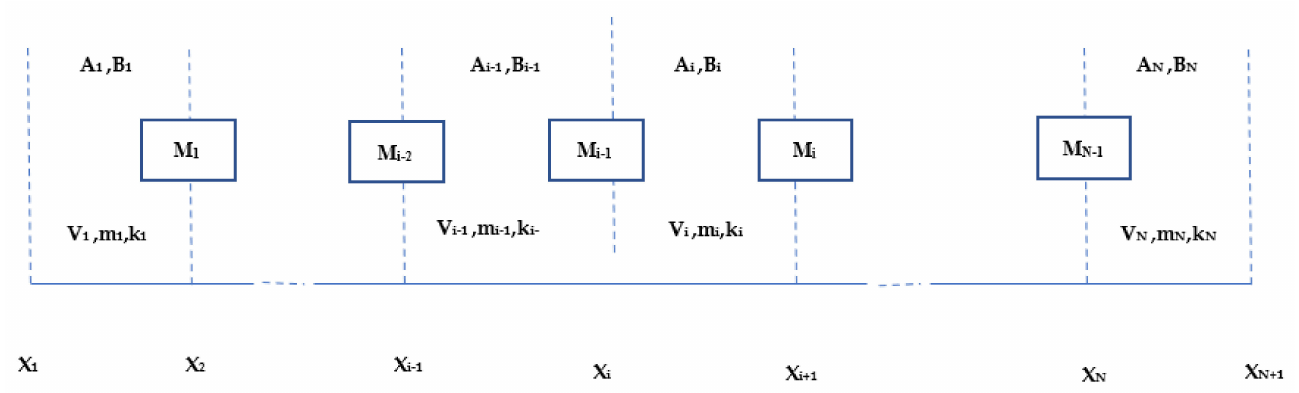
Figure 1. Potential profile of GaAs/Ga 1 − x Mn x As multibarrier